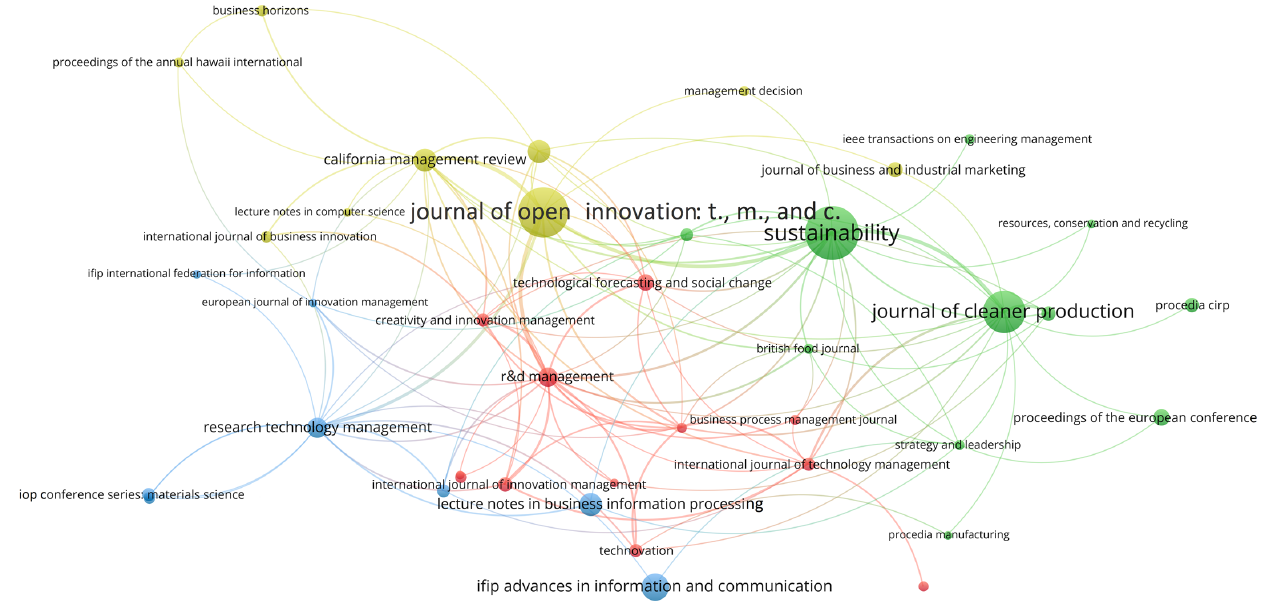
Figure 9. Citation network of sources in the BM&OI literature.